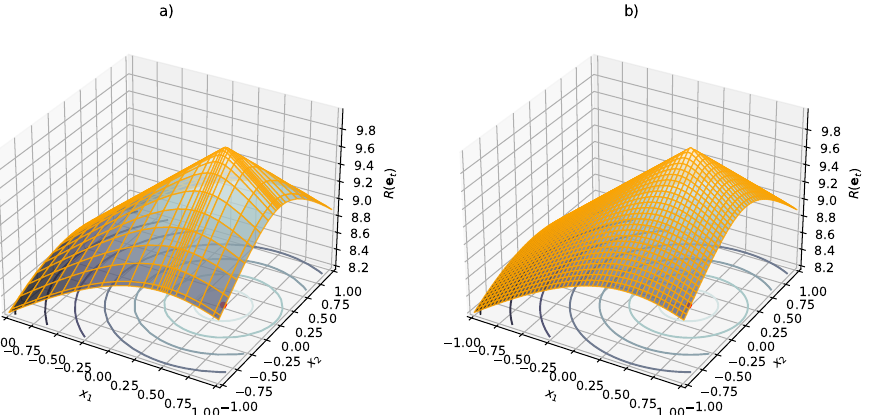
Figure 2. Level sets for vertical rocket landing were obtained with ( a ) the variable box method using 576 boxes, and ( b ) the classical box method using 40,000 boxes, both tuned to obtain similar final results. The dramatic reduction in the number of boxes achieved using our proposed variable method results from the symmetrical higher resolution around the goal box, which yields a higher reward in areas with zero